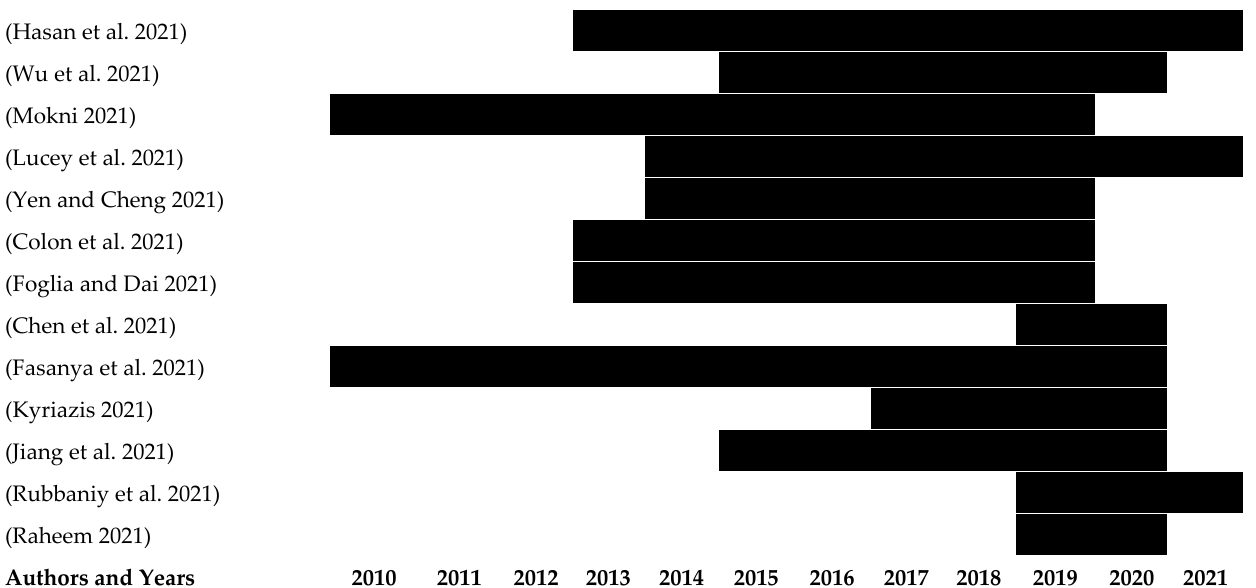
Figure 3. Data coverage in years. Note: This figure portrays the data covered by previous research from 2010 to 2021, left side is indicating the author names and year of publication and black horizontal bars are indicating set data covered by studies in years.